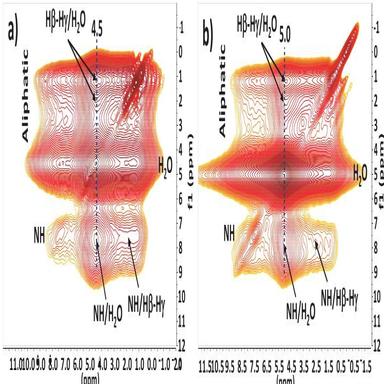
2D 1H SQ-MAS (NOESY) NMR spectrum (νr = 60 kHz, mixing time 18 ms) of (a) Dm-dentin and (b) Hu-dentin.